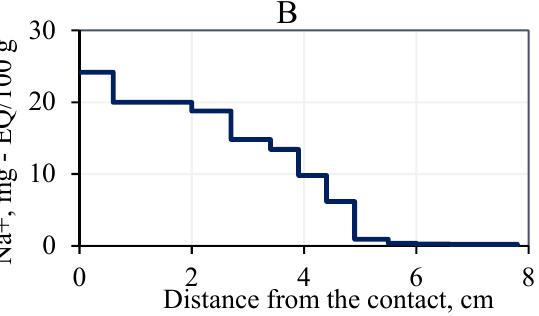
Figure 9. Variations of Na + contents along frozen hydrate-bearing sand samples after four hours of interaction with 0.1 N ( A ) and 0.2 N ( B ) NaCl solutions, at − 6.5 °C and 4.0 MPa. Interaction with solutions of higher concentrations at 4 MPa and − 6.5 °C led to more active salt migration and more rapid dissociation of pore methane hydrates: all hydrate dissociated to distances of 1.6 cm and 4.4 cm from the contact after 4 h of interaction with 0.1 N and 0.2 N NaCl solutions, respectively (Figure 10).